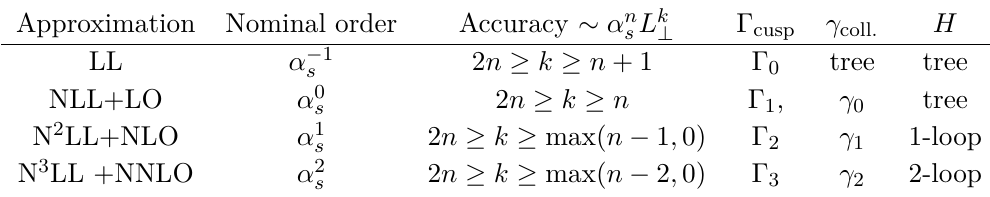
Table 1 . Counting of orders in the resummation, adapted from ref. [26]. The second column indicates the nominal order when counting L are included. The last three columns show the necessary additional anomalous dimensions and hard function corrections in each successive order. The requisite anomalous dimensions are provided in appendix